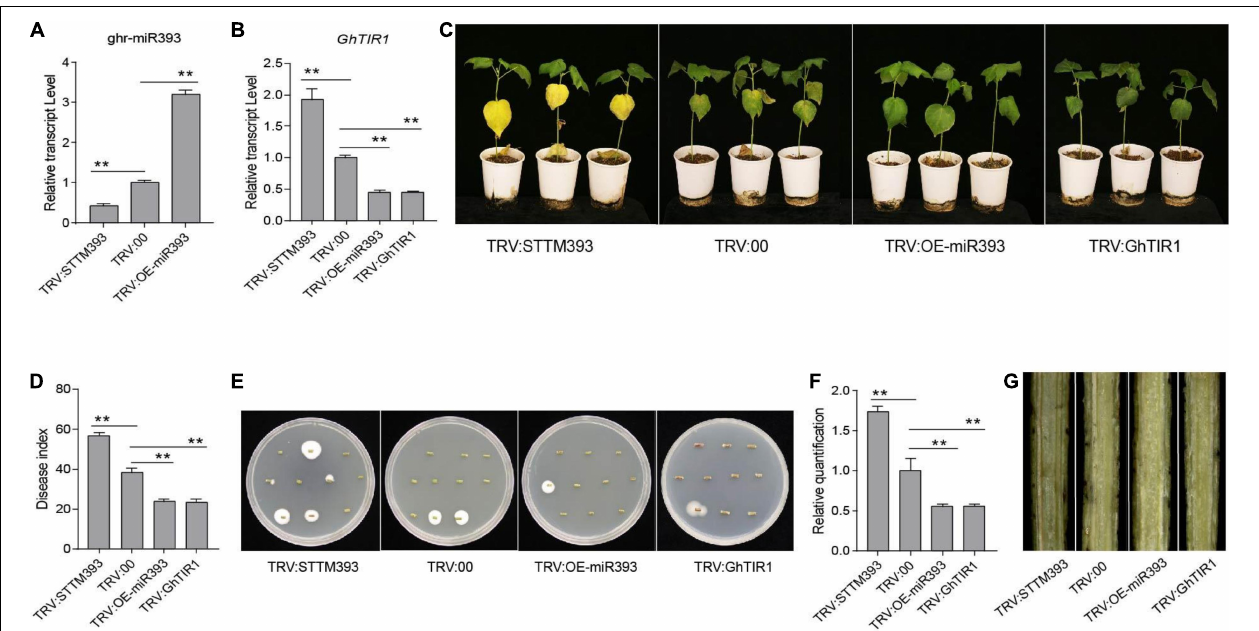
FIGURE 4 | The cotton miR393-GhTIR1 module mediated plant resistance against Verticillium dahliae . (A) Relative expression of ghr-miR393 in the TRV:STTM393 and TRV:OE-miR393 plants compared to TRV:00 plants. (B) Relative expression of GhTIR1 in the TRV:STTM393, TRV:OE-miR393, and TRV:GhTIR1 plants compared to TRV:00 plants. (C) Disease symptoms of plants at 21 dpi. (D) The disease index of the plants at 21 dpi. (E) Fungal recovery assays. Stems from cotton plants at 21 dpi were placed on PDA. Photos were taken after 5 days. (F) The relative V. dahliae fungal biomass in the infected stems was quantified by qRT-PCR. GhUB-7 and V. dahliae β -tubulin were used as reference genes. (G) Longitudinal sections of cotton stems at 21 days. The error bars indicate the SD of three biological replicates. Statistical significance was determined by Student’s t -test: ** P <